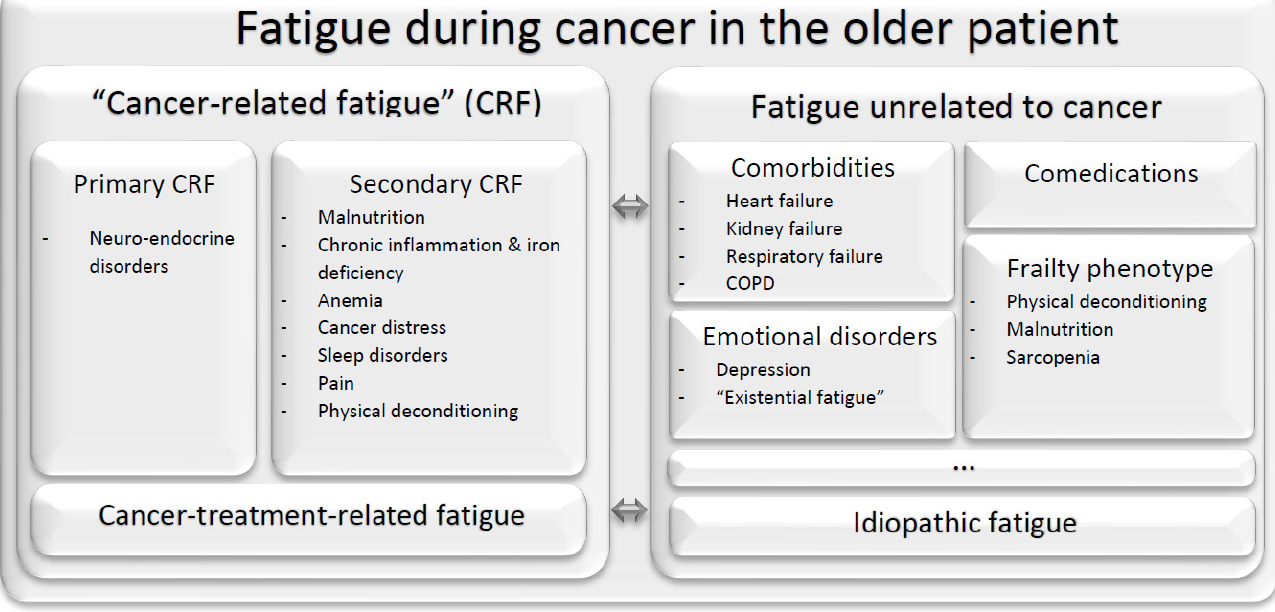
Figure 1. The multiple etiologies of fatigue in older patients with cancer. Abbreviations: CRF: cancer-related fatigue; COPD: chronic obstructive pulmonary disease.